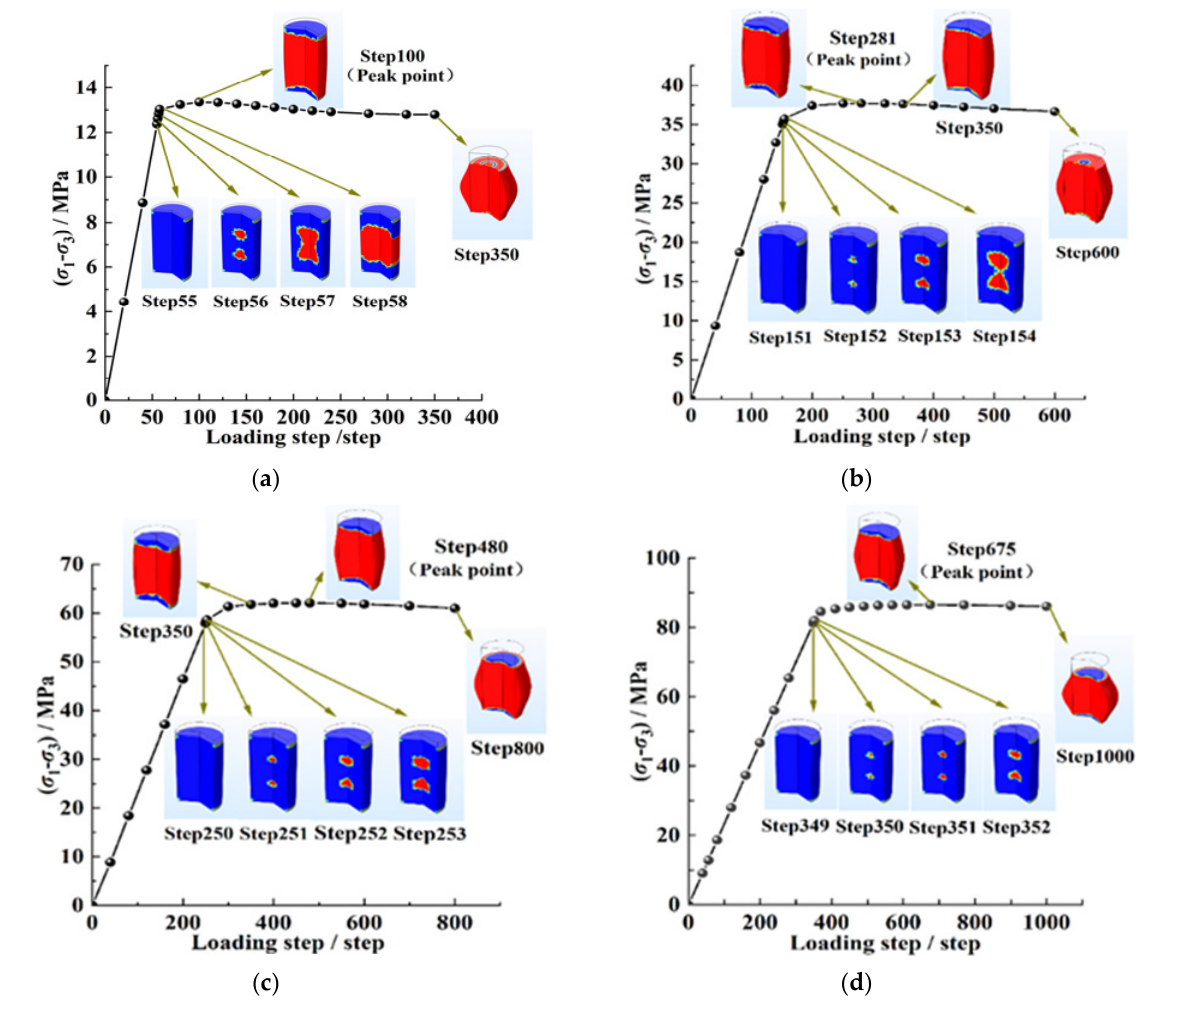
Figure 9. Plastic deformation of coal under different confining pressures varied with loading steps: ( a ) 4 MPa of confining pressure; ( b ) 12 MPa of confining pressure; ( c ) 20 MPa of confining pressure; ( d ) 28 MPa of confining pressure.